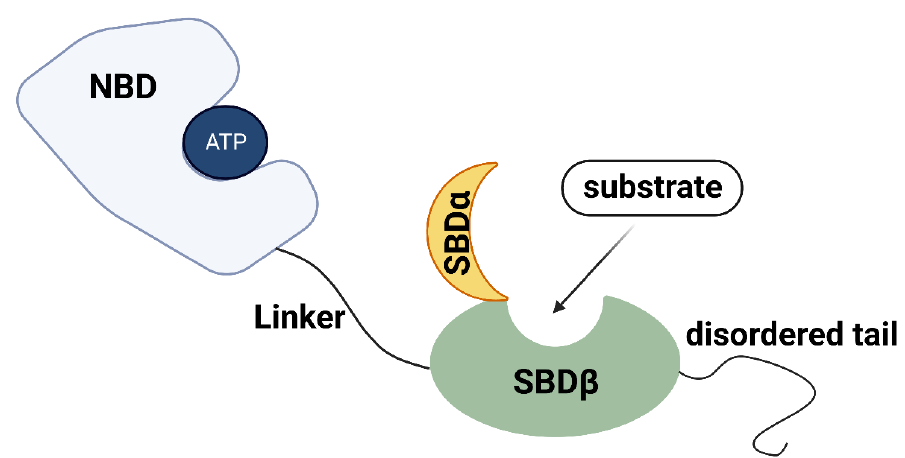
Figure 1. Schematic diagram of HSP70 structure domain. A typical HSP70 domain structure consists of NBD, linker, SBD, and a disordered tail. NBD binds and hydrolyzes ATP to control the lobe movements. Linker is essential for the NBD conformational changing. SBD has two functional parts and works together on substrate binding. The disordered tail interacts with specific cofactors to fulfil HSP70 functions. Nucleotide-binding domain (NBD). Substrate-binding domain (SBD).